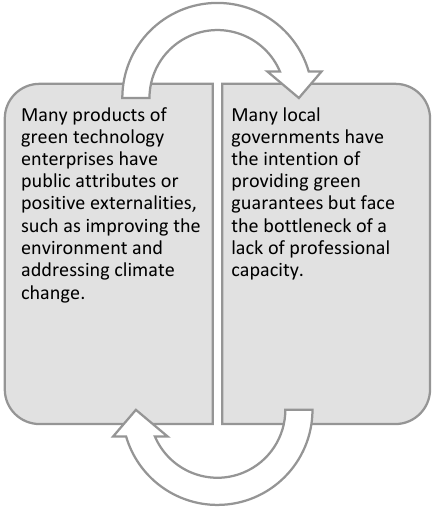
Figure 3. The reasons for the importance of green technology innovation.